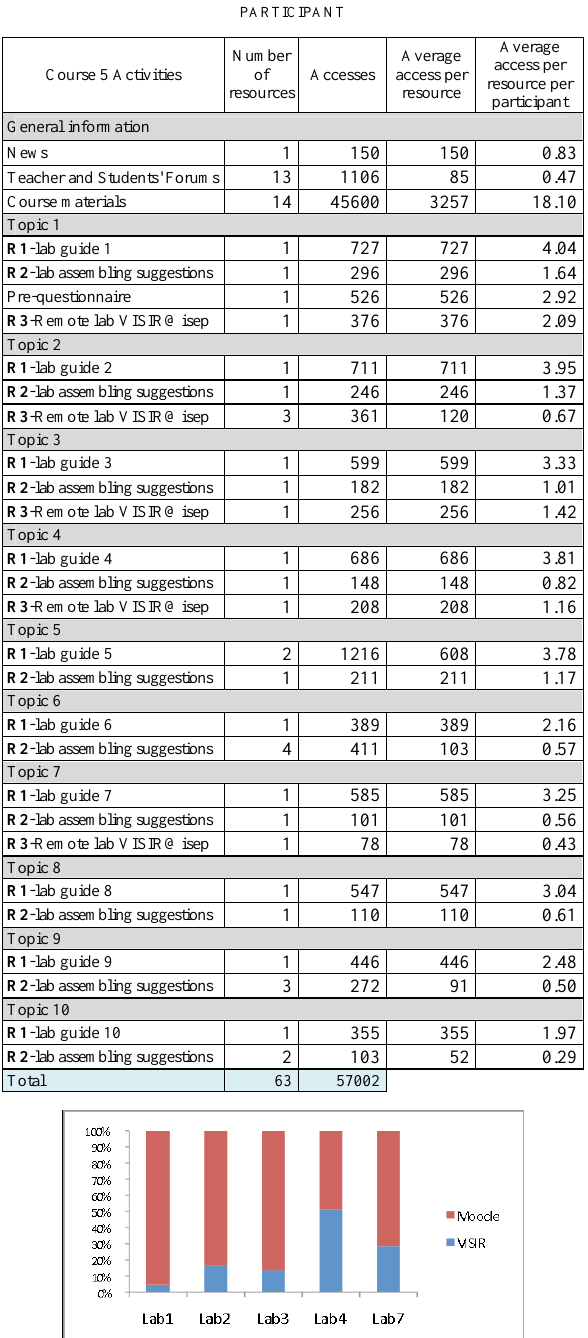
TABLE III. C OURSE 5: M OODLE ACESSES PER RESOURCE AND PARTICIPANT